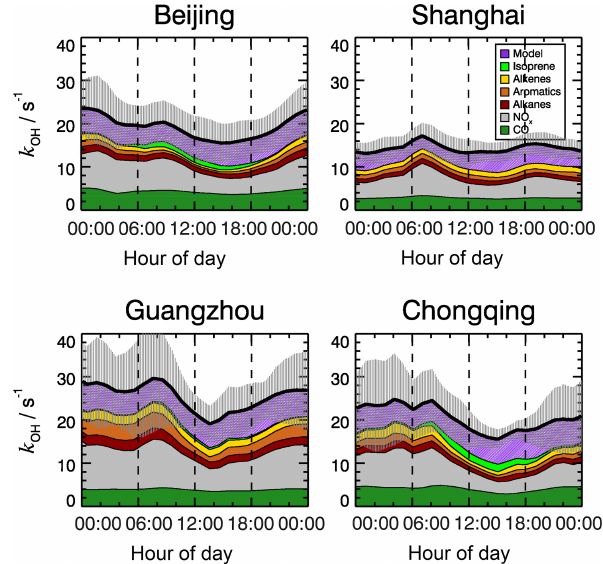
Figure 3. Mean diurnal profiles of the contributions from all mea- sured species to the modeled OH reactivity in Beijing, Shanghai, Guangzhou, and Chongqing. The filled areas represent different at- mospheric constituents. The model denotes the sum of the model- generated species such as formaldehyde and